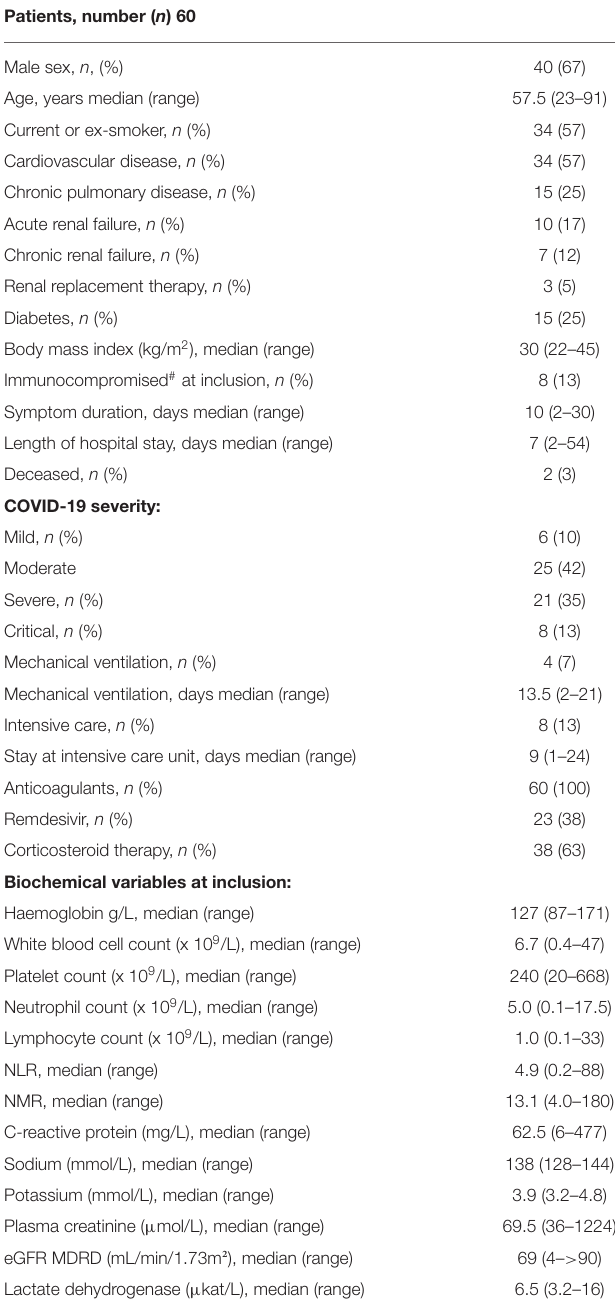
TABLE 1 | Clinical characteristics of and biochemical variables in the patient cohort. Patients, number ( n )